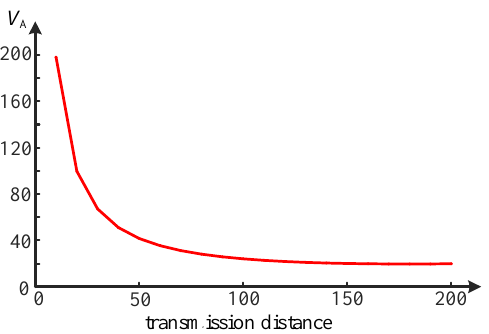
Figure 14. The V A variation with transmission distance. According to the guidance in Figure 14, V A is adjusted so that the magnetic flux density reaches below 27 µ T at different transmission distances. The variation curves of magnetic flux density at different transmission distances are given in Figure 15. Blue indicates no shielding, red represents the case with double-coil active shielding but without the dynamic shielding scheme (here V A = 24 V and the initial transmission distance is 100 mm), and yellow represents the case with double-coil active shielding and with the dynamic shielding scheme to adjust V A . Lines indicate calculated values, and dots indicate measured values.